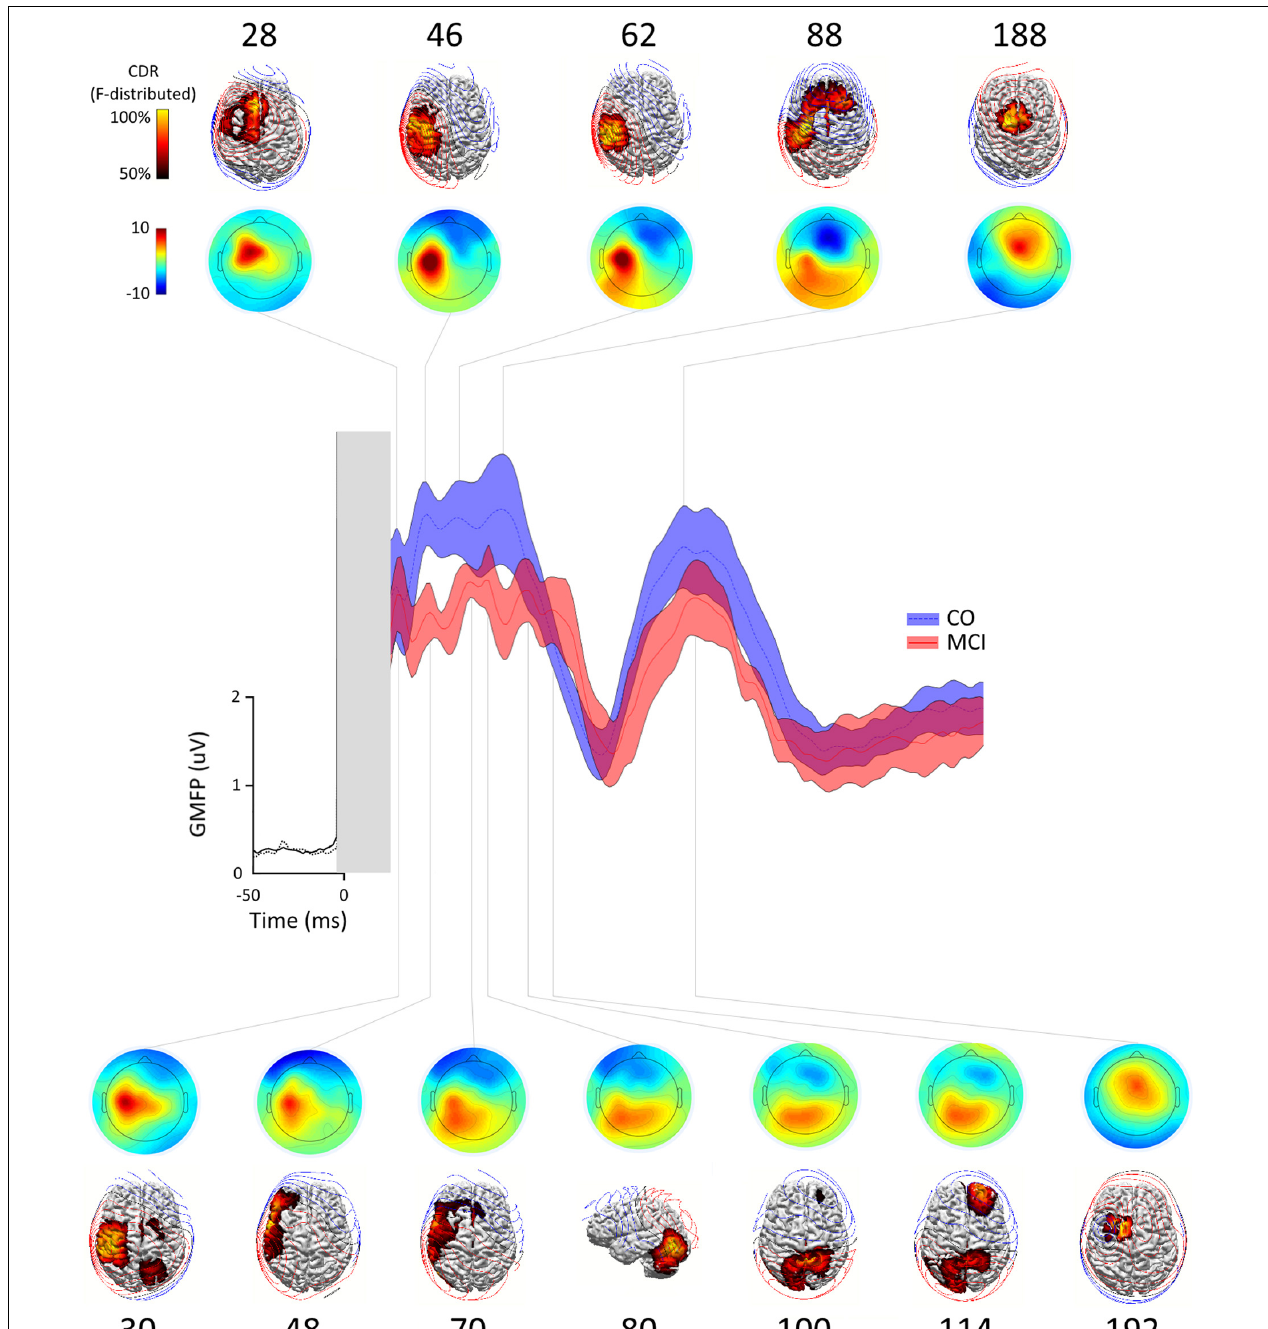
FIGURE 1 | Global mean field power (GMFP), scalp distribution maps, source localizations in control subjects, and the patients with amnestic mild cognitive impairment (aMCI). Scalp distribution maps and source localization of the activity occurring during each peak of the GMFP obtained after the transcranial magnetic stimulation (TMS) of left M1 in healthy subjects (CO, blue trace ± SE) and patients with aMCI (aMCI, red trace ± SE). At each time point, the source localizations were autoscaled and thresholded at 50% to highlight the maximum current sources. In CO, the current maxima (reflecting the maximum neuronal activity) shifted from the stimulated M1 to the ipsilateral premotor/prefrontal cortex border (28 ms), back to the ipsilateral sensory motor cortex (46 ms), becoming more focused on the sensory cortex (62 ms), spreading to the bilateral premotor regions and dorsal prefrontal areas (88 ms), finally focusing on the central midline (188 ms). In MCI, the current maxima at 30 ms poststimulation was still located in the ipsilateral sensory motor cortex expanding to ipsilateral premotor and parietal region and in supplementary motor area (SMA) and contralateral premotor and parietal regions, and then shifted to ipsilateral lateral sensorimotor and lateral premotor and prefrontal regions (48 and 70 ms), to ipsilateral occipito-cerebellar junction, superior parietal lobules bilaterally (100 ms), contralateral prefrontal cortex (114 ms), and finally to ipsilateral premotor region/pre-SMA.